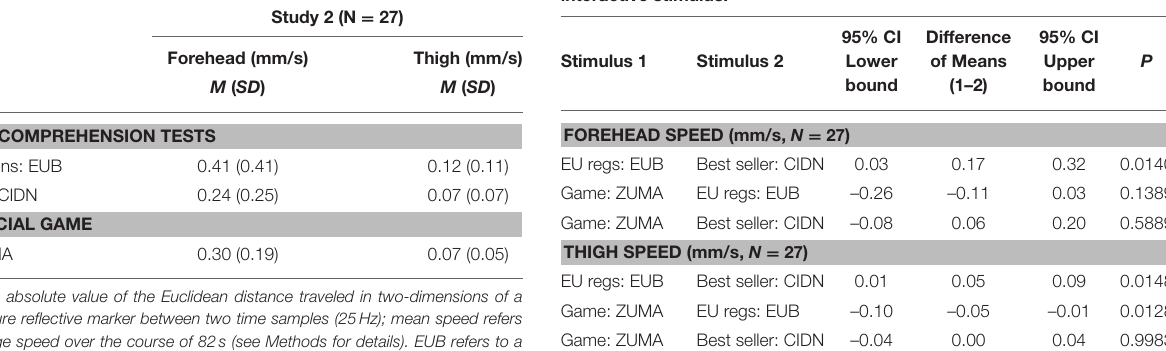
TABLE 10 | Mean speed of movement elicited by each interactive stimulus. TABLE 11 | Comparison of speeds of movements elicited by each interactive